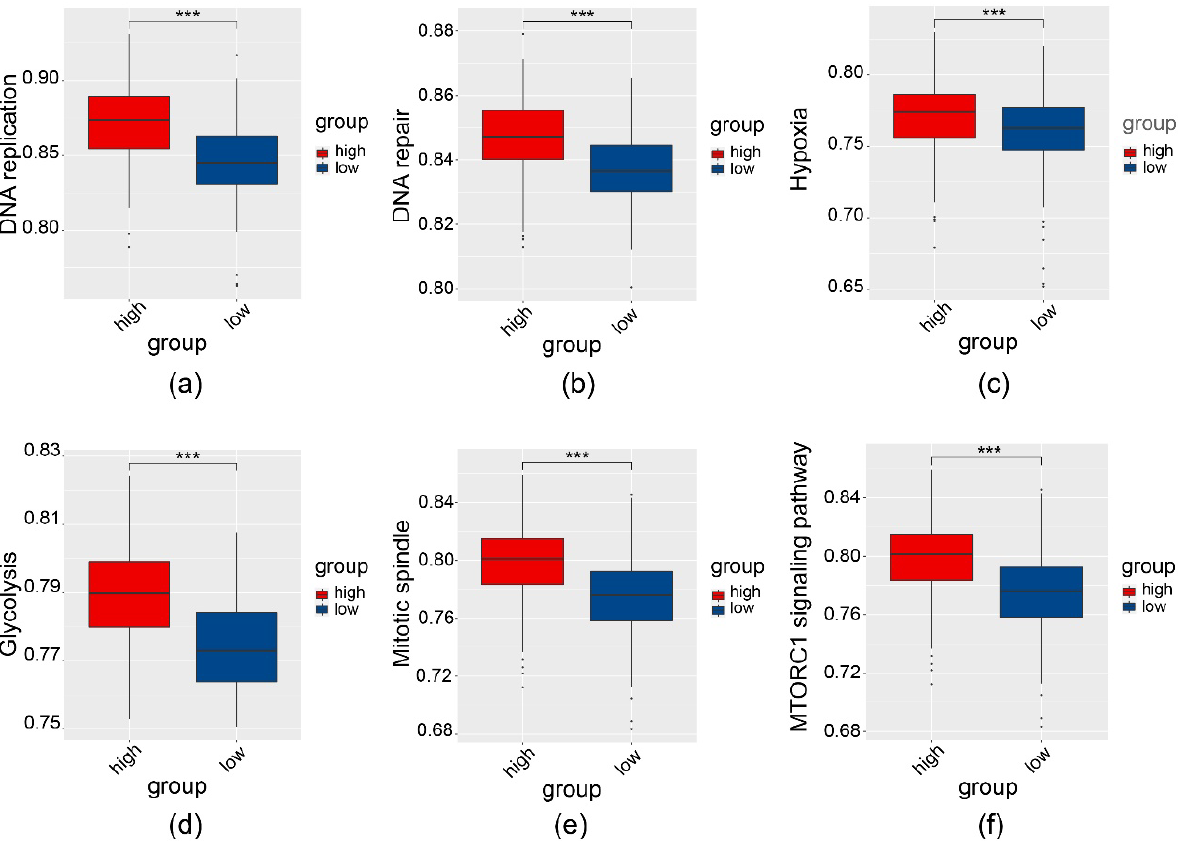
Regarding molecular and cellular characteristics, GSVA unveiled that several malignancy-related events were significantly altered in the high-risk group compared with the high-risk group (Figure 5a–i).